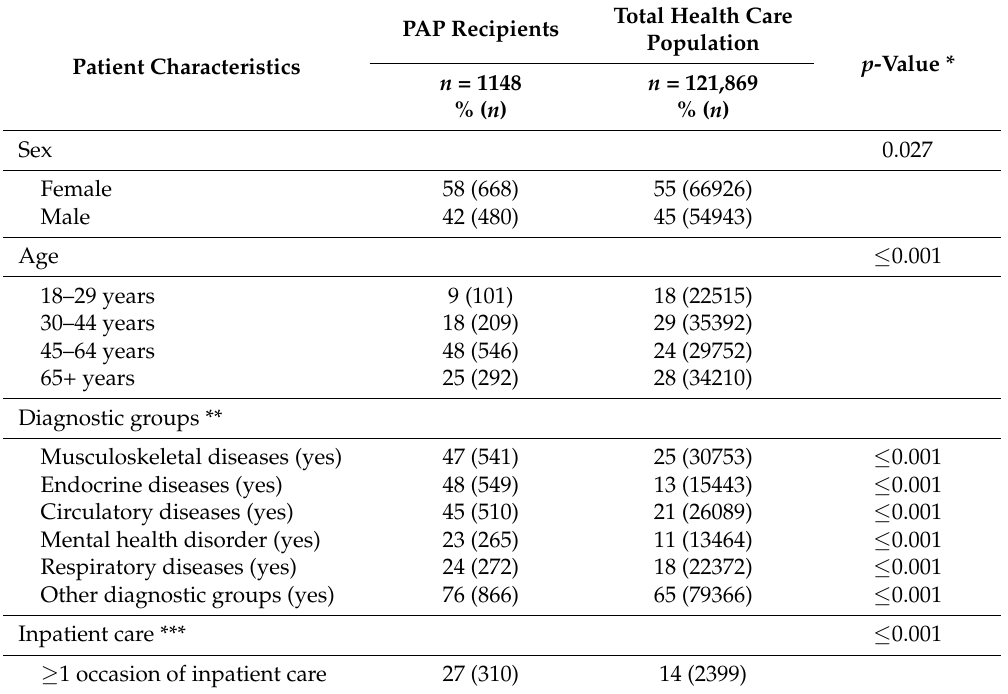
Table 2. Differences in characteristics between PAP recipients and the total health care population in